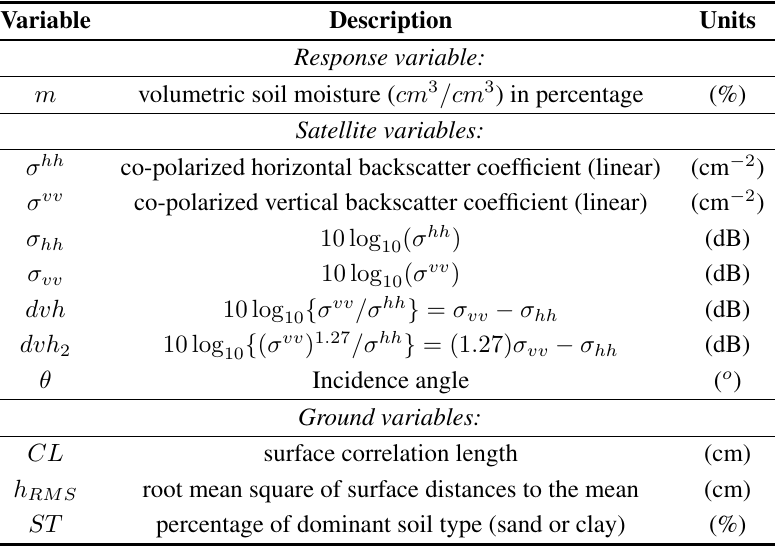
Table 1. Summary of the relevant SAR and ground-based measurement variables and their mathematical notation for the Casselman agricultural monitoring site.